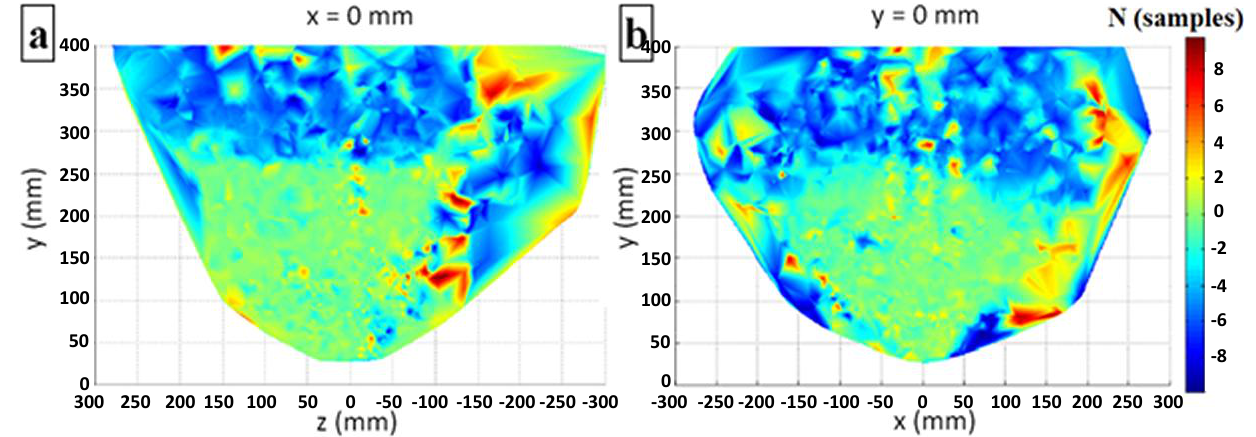
Figure 12. Distance deviation distributions at ( a ) x = 0; and ( b ) y = 0.